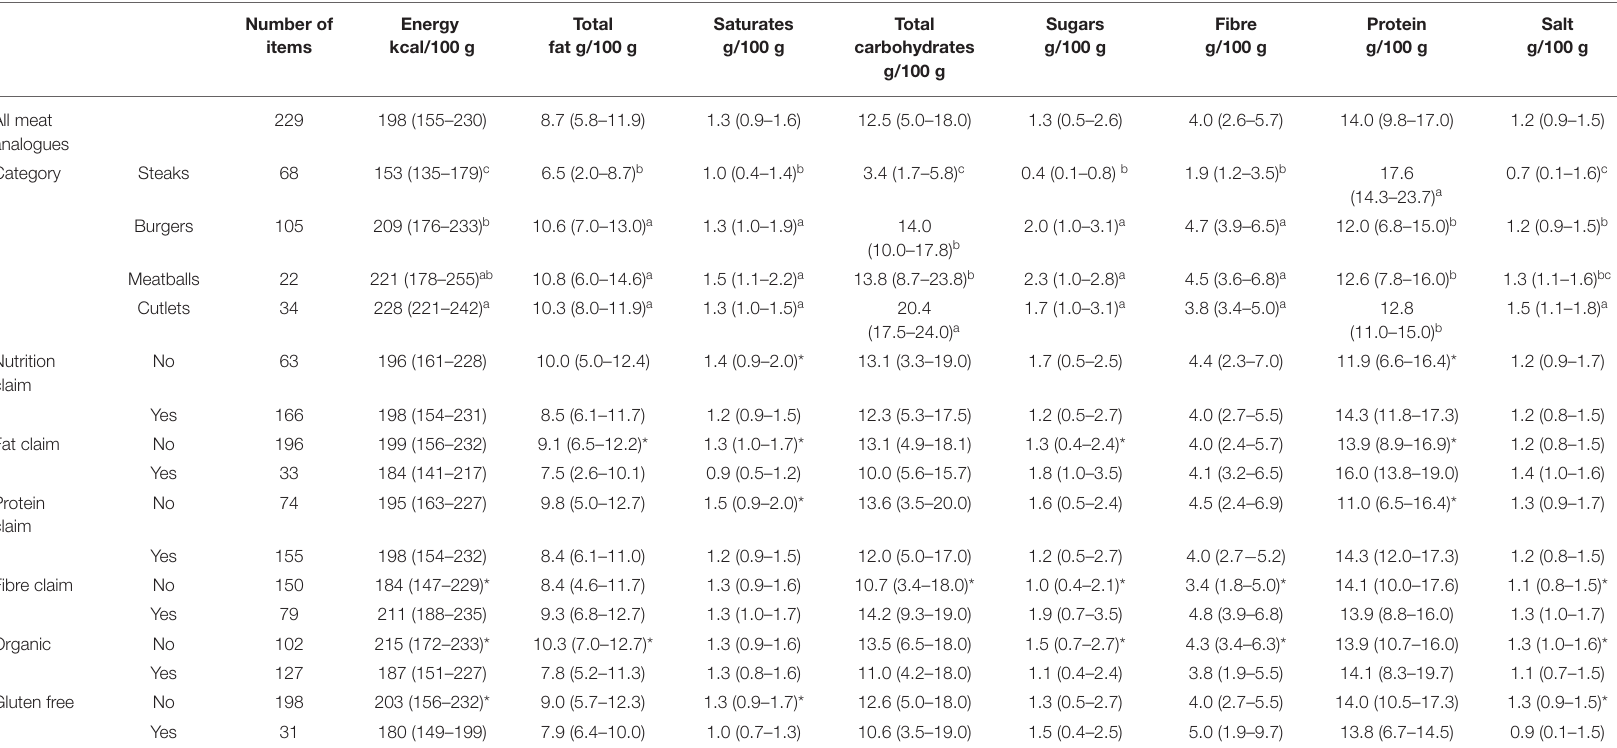
TABLE 1 | The number of items and nutrition declaration [according to the Council Regulation (EU) 1169/201 (14)] of plant-based meat analogues reported for each category, presence of nutrition claim, organic declaration, and gluten-free indication.